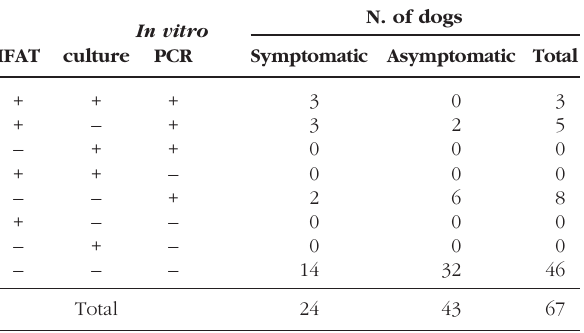
Table I. – Clinical status, serology, in vitro culture, and PCR results in a canine population living in an area of Kairouan. and PCR) performed on blood were given in Table I. Only, three dogs were found to be positive by all while eight dogs were positive only by PCR. Altoge- ther, 16 dogs (20.9 % of the cases) were positive by PCR. Among the samples negative by PCR, one case of PCR inhibition was detected and was resolved by five-fold dilution and was negative. Eight dogs (11.9 %) were positive by IFAT with dilutions between 1/80 and 1/2560. Only three strains (4.5 %) were isolated by in vitro culture and were identified by isoenzymatic method as Leishmania infantum MON-1. Within posi- tive cases, eight dogs (50 %) were symptomatic with two or more signs evoking CanL (loss of weight, ony- chogriffosis, lymph node, and spleen enlargement). The other infected dogs (50 %) were asymptomatic.